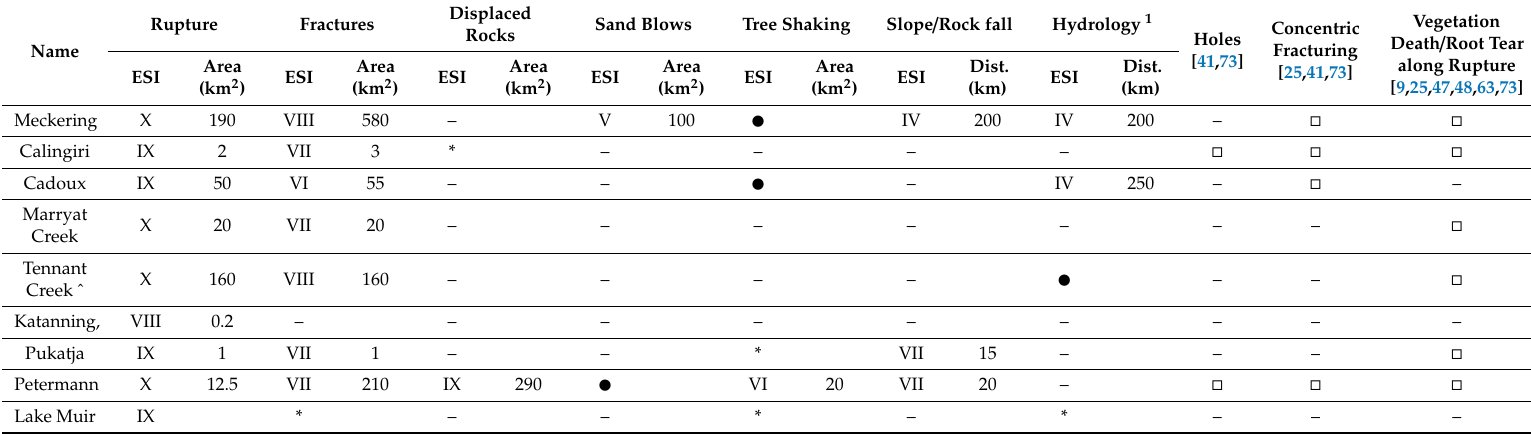
Table 7. Summary of environmental e ff ects described for each rupture, assigned ESI level, and approximate area around, or distance from,